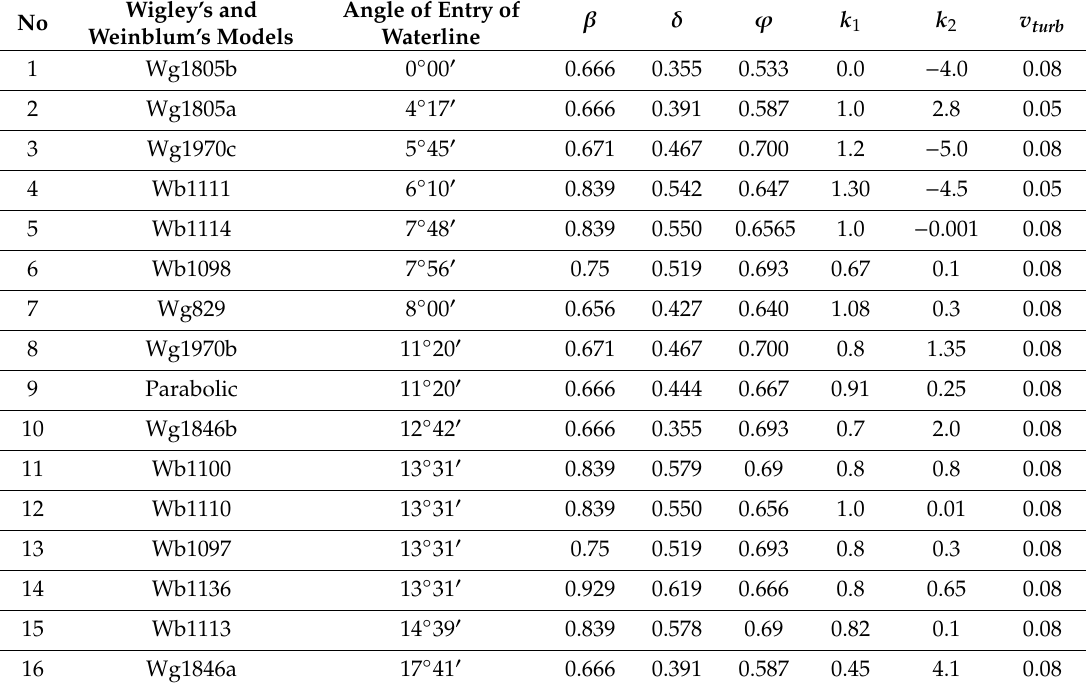
Table 5. Data on the models of Wigley and Weinblum Wigley’s model: L = 4.876m, B = 0.457